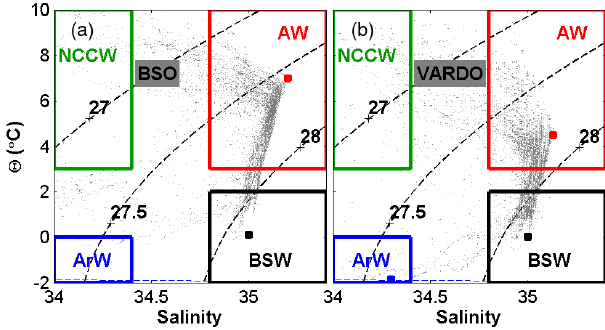
Figure 4. Potential temperature–salinity diagrams in August– September for the 1980–1985 period. (a) BSO section (b) Vardø section. Red dots: ideal Atlantic Water; black dots: ideal Barents Sea Water; and blue dots: ideal Arctic Water.